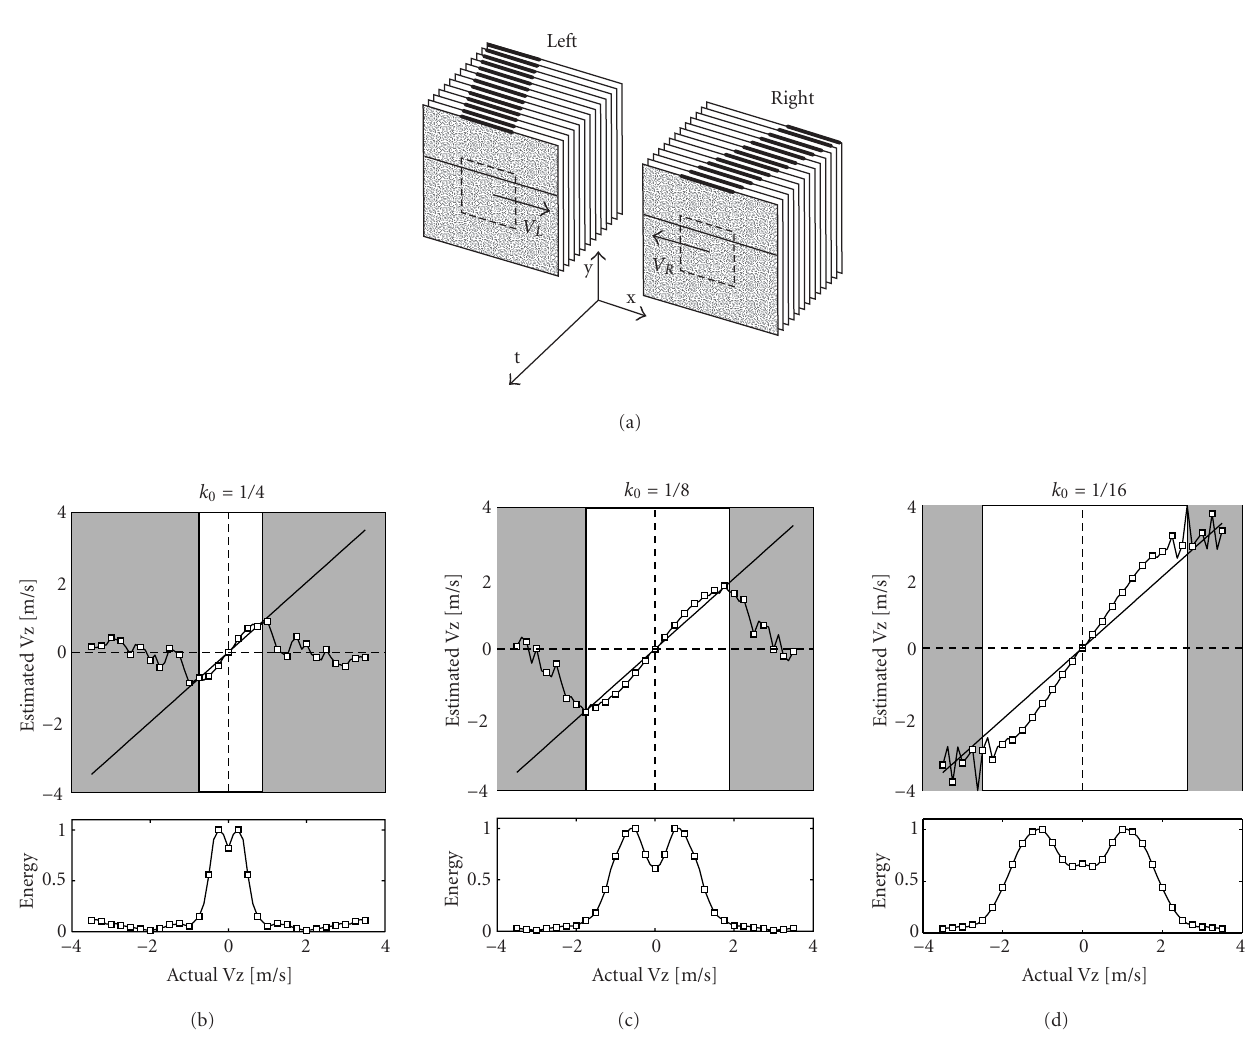
Figure 8: Results on synthetic images. (a) Schematic representation of the random dot stereogram sequences where a central square moves, with speed V Z , forward and backward with respect to a static background with the same random pattern. (b–d) The upper plots show the estimated speed as a function of the actual speed V Z for the three considered Gabor-like filters ( k 0 = 1 / 4, k 0 = 1 / 8, and k 0 = 1 / 16); the lower plots show the binocular average energy taken as a confidence measure of the speed estimation. The ranges of V Z for which the confidence goes below 10% of the maximum are evidenced in the gray